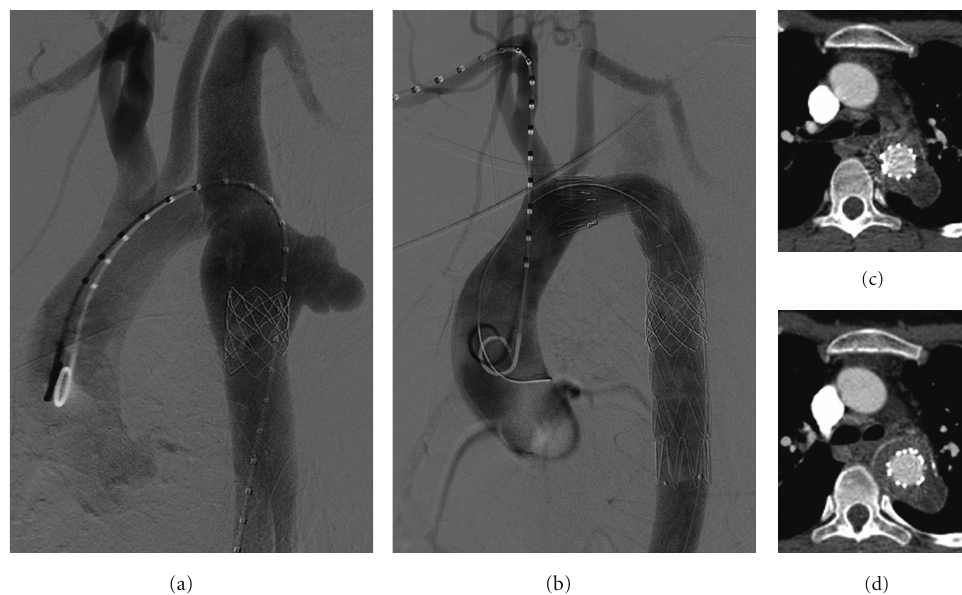
Figure 1: (a) Aortic angiography showing an angulated aortic arch and a small caliber thoracic aorta. A lobulated aortic pseudoaneurysm extends proximally to the left subclavian artery, and a large caliber balloon-expandable stent is adhered to the aortic wall at its distal end. (b) Final result after completion of the carotid subclavian bypass and exclusion of the pseudoaneurysm. A heparin-related leak can be found which extends to the left subclavian artery. (c) and (d) Angio-CT images showing exclusion of the pseudoaneurysm without evidence of